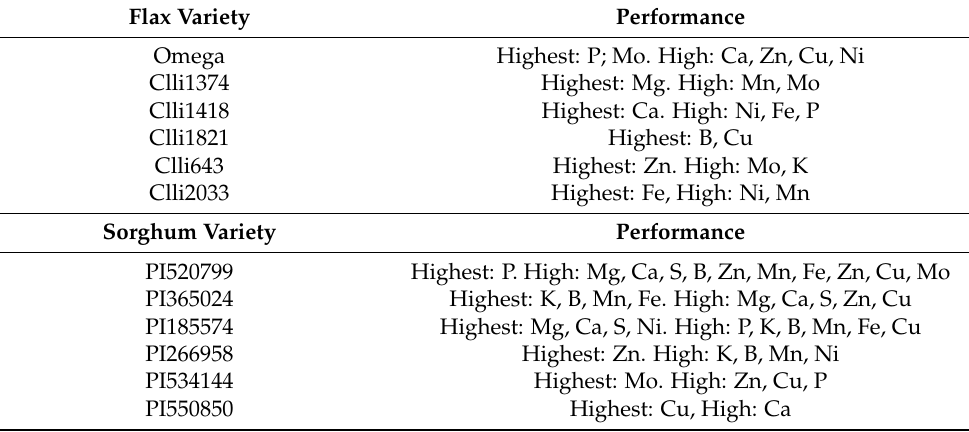
Table 3. A set of top six superior varieties of flax and sorghum with superior seed mineral concen- tration. Highest, the highest mean for that specific element; High, considerably higher mean than other